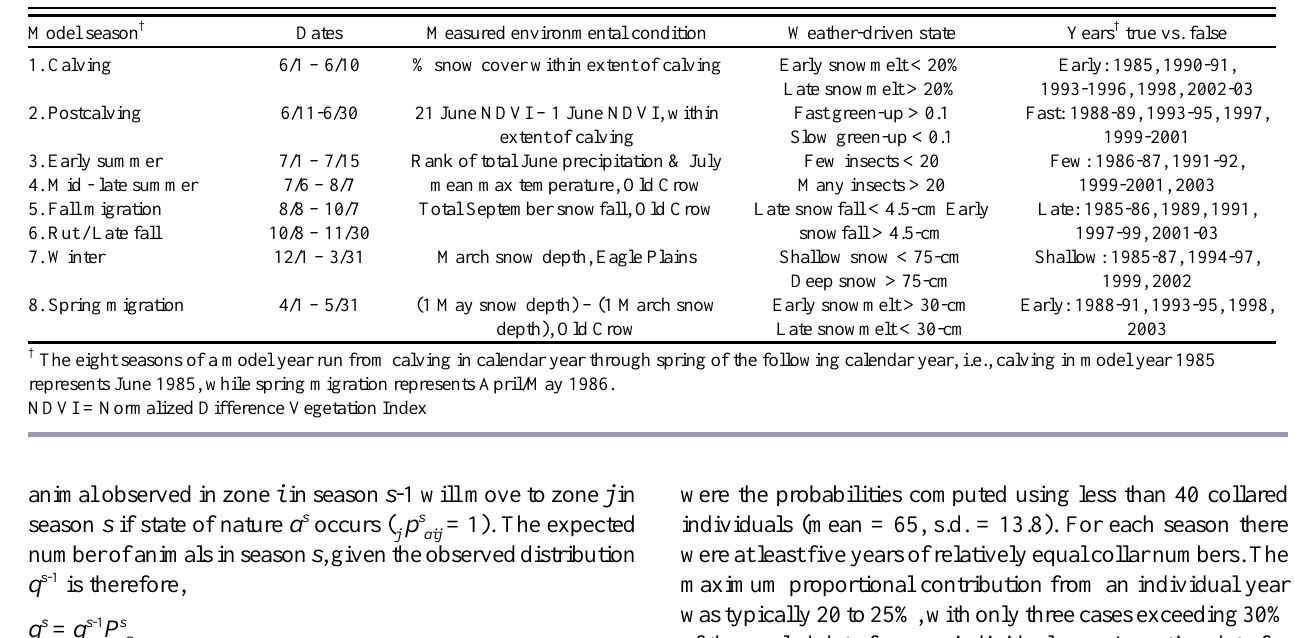
Table 3 . Environmental condition classes and climate variables for eight seasons for the Porcupine Caribou Herd, based on data from McNeil et al.